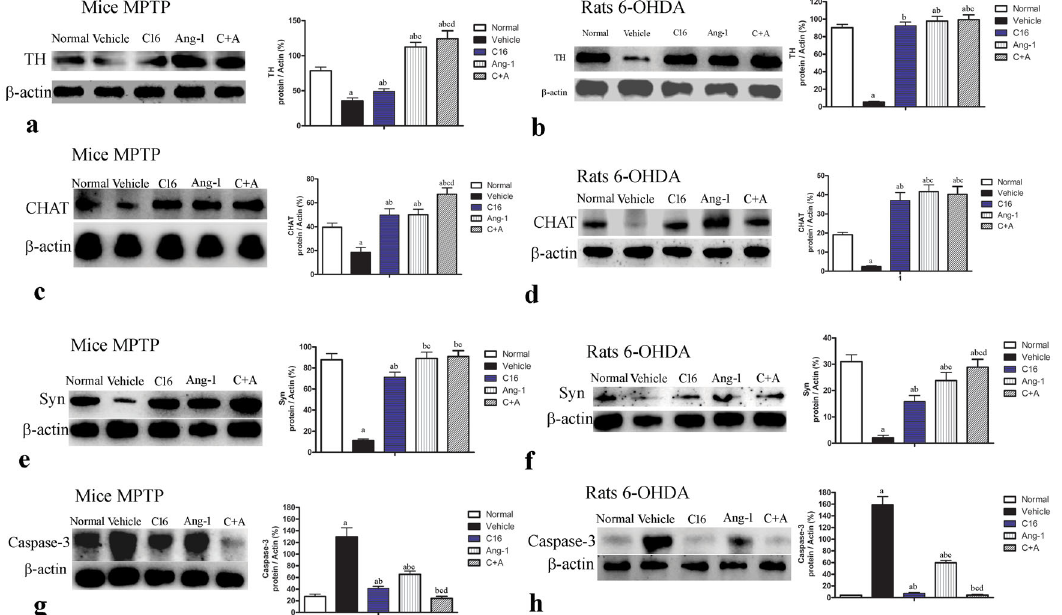
Fig. 12 C16 in combination with Ang-1 treatment improved the expression of TH, CHAT, Syn but inhibited the expression of active caspase-3. The expression of TH ( a : mice; b : rats), CHAT ( c : mice; d : rats), Syn ( e : mice; f : rats), and active caspase-3 ( g : mice; h : rats) were measured by western blot. Treatment with C16, Ang-1, and C16 plus Ang-1 upregulated TH, CHAT and Syn, but reduced the expression of active caspase-3 in both mouse and rat PD models. a p < 0.05 versus the normal control group; b p < 0.05 versus the vehicle group; c p < 0.05 versus the C16-treated group; d p < 0.05 versus the Ang-1-treated group. TH protein: 58 kDa; CHAT protein: 82 kDa; Syn protein: 34 kDa; Caspase-3 protein: 32 kDa; β -actin protein: 42 kDa; TH, tyrosine hydroxylase; CHAT, choline acetyltransferase; Syn, synaptophysin; C16, peptide (KAFDITYVRLKF) that can selectively bind integrin ανβ 3; Ang-1,